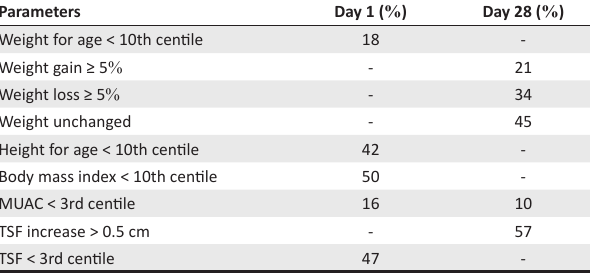
TABLE 1: Anthropometric parameters on days 1 and 28. Parameters